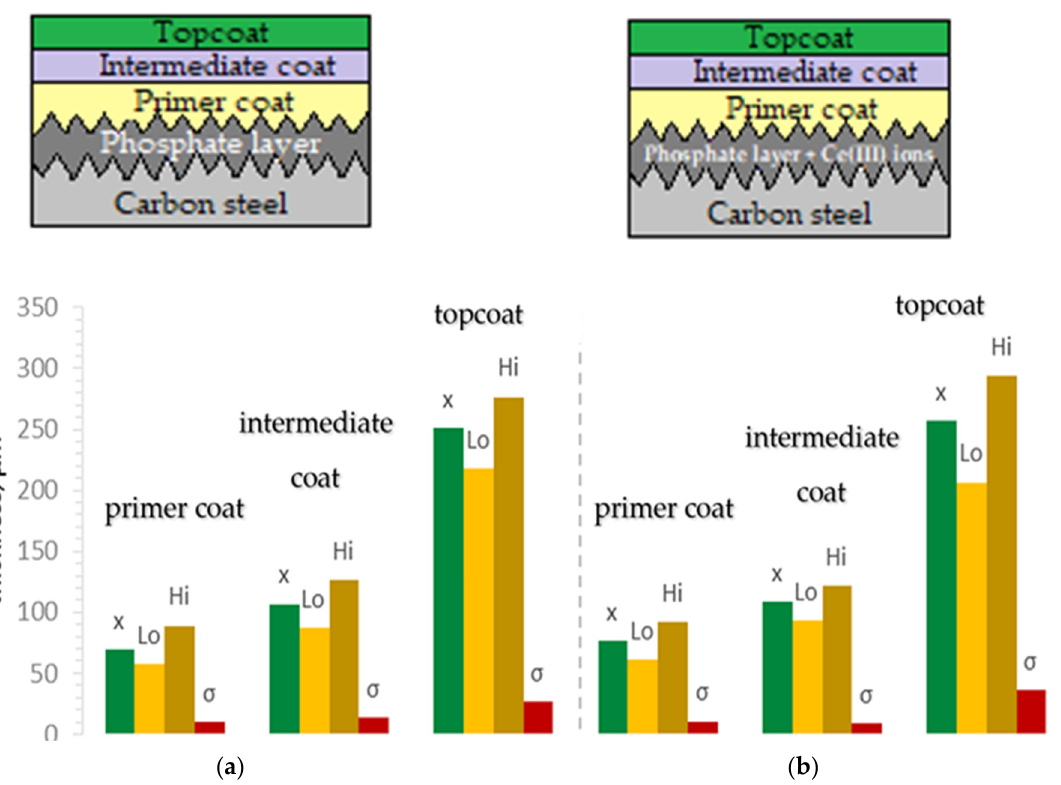
Figure 4. Scheme of steel samples with phosphate layer and three-layer epoxy coating. Parameters of thickness for applied primer, intermediate coat, and topcoat on ( a ) phosphated and ( b ) phosphate samples with Ce 3+ ions.